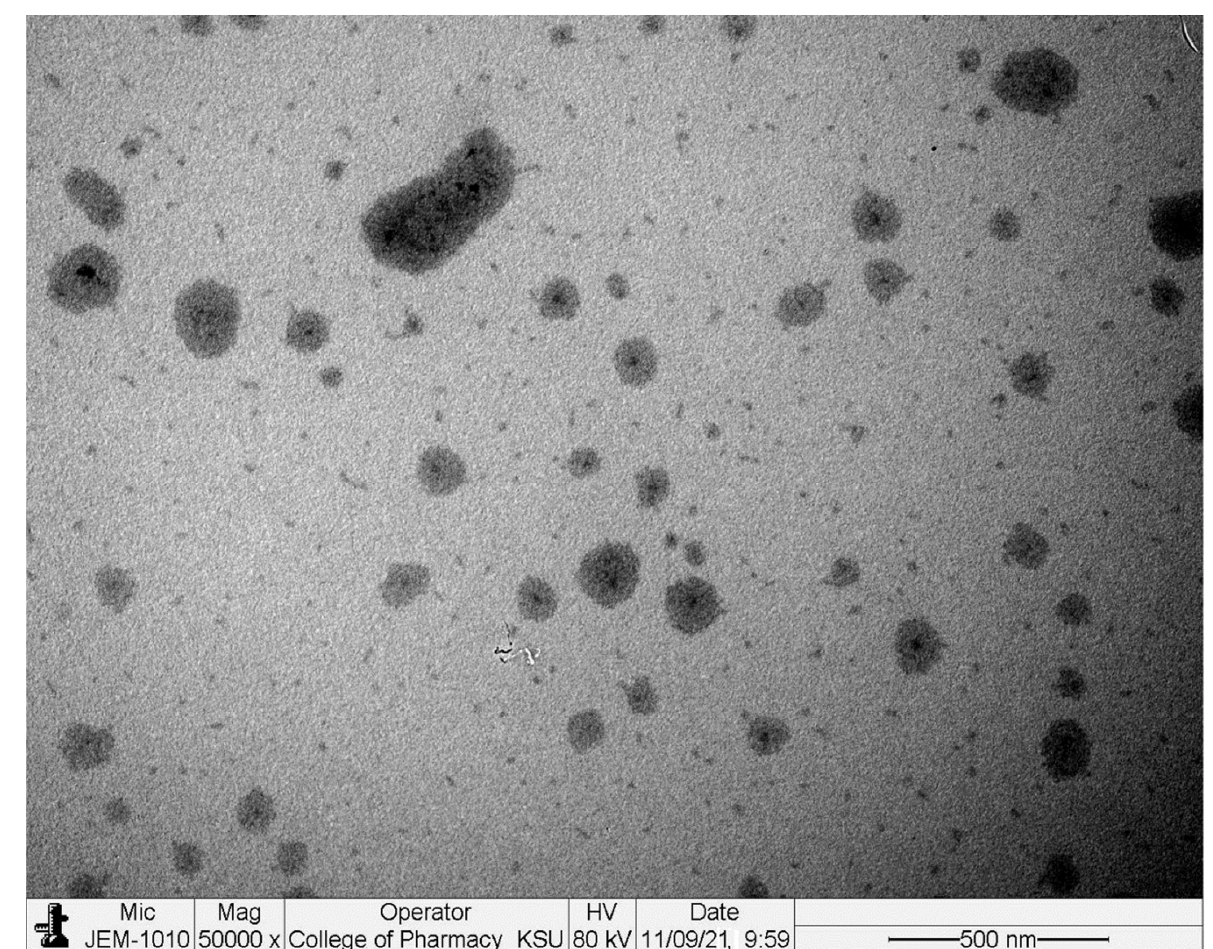
Figure 4. TEM images of optimized NEs (CRB-NE1).